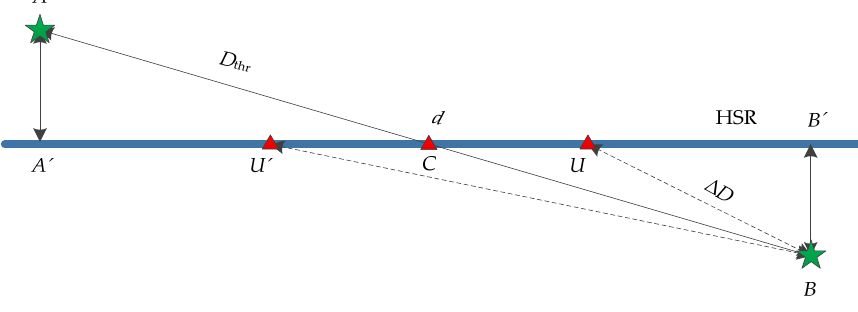
Figure 11. Diagram of the relation between Δ D and D thr